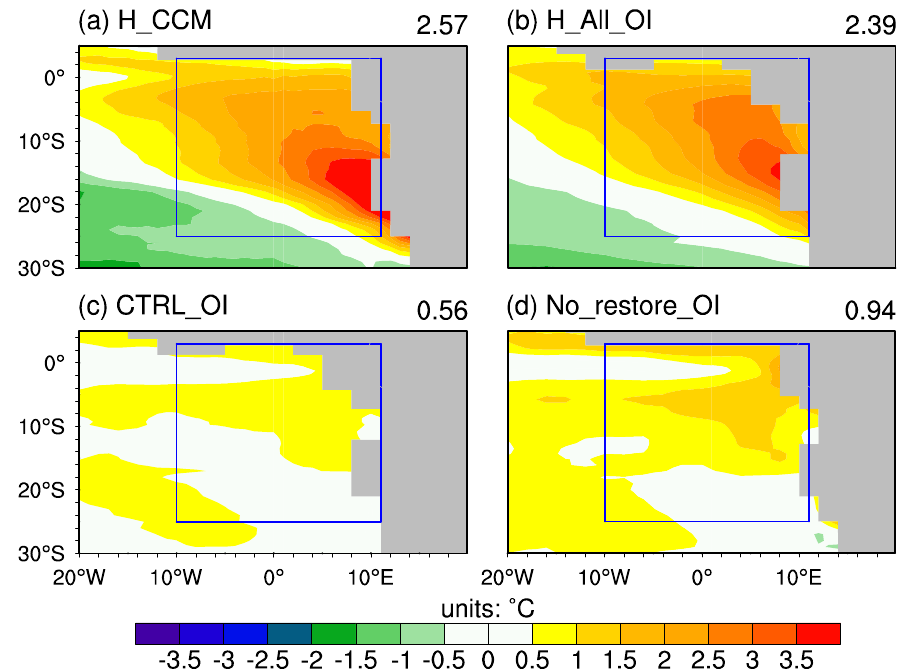
Figure 6. The same as Figure 5 except that it is for the annual mean and the blue box denotes the sub-region (25° S–3° N, 10° W–10° E) of the Southern Atlantic region.